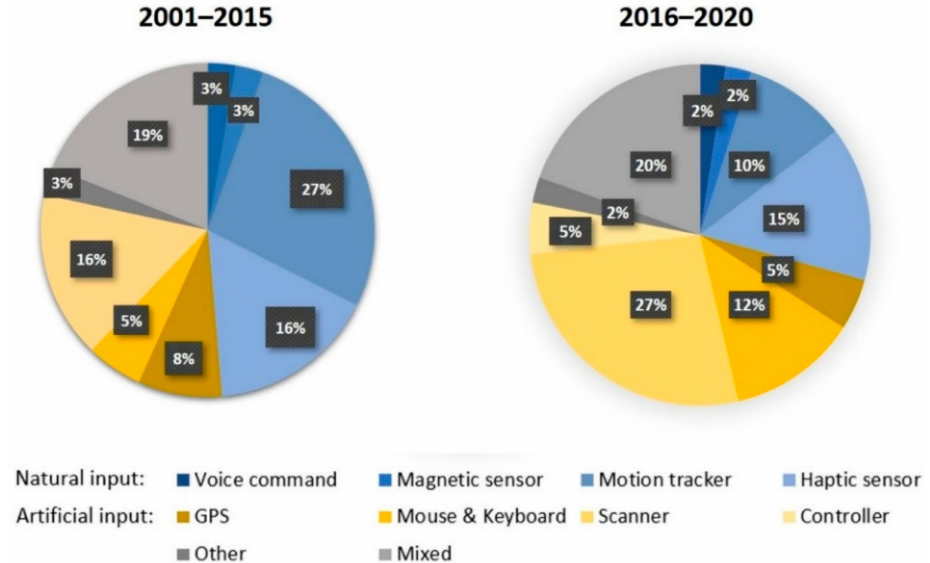
Figure 4. Input devices of AR-supported instruction from 2001 to